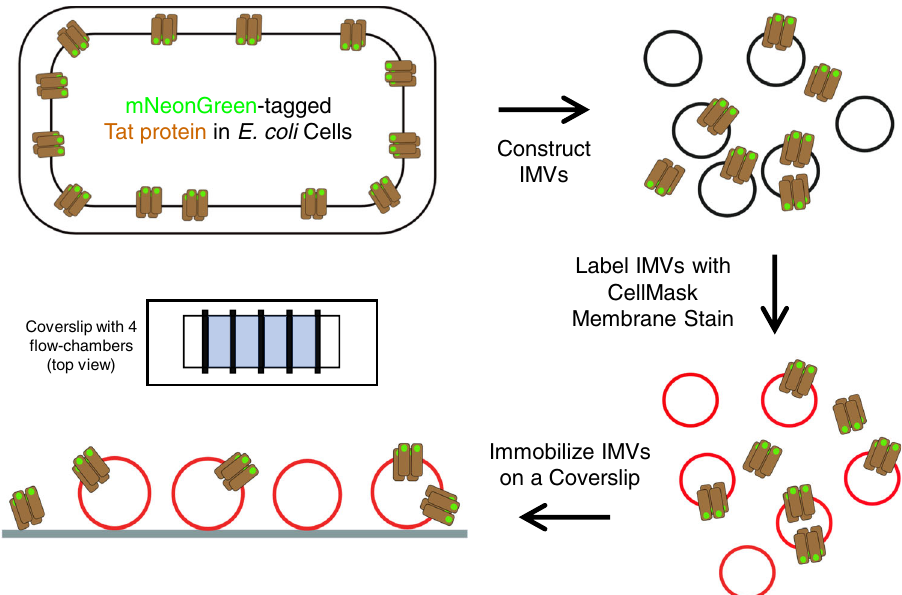
Fig. 1 Experimental strategy. IMVs were obtained from E. coli cells overproducing TatAB mNeon C or TatABC mNeon . After staining the membrane with CellMask, the IMVs were added to a fl ow chamber constructed on a microscope coverslip. The adsorbed IMVs were washed before